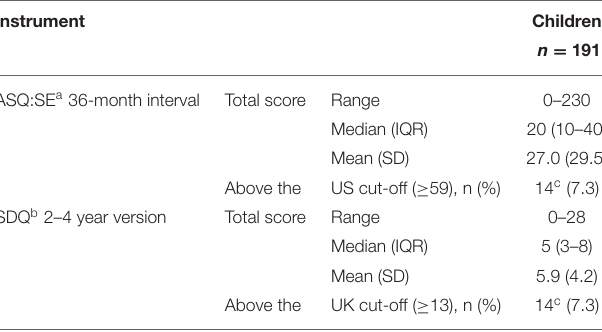
TABLE 1 | Descriptive of ASQ:SE a and SDQ b in a population-based study of 3-year-olds.